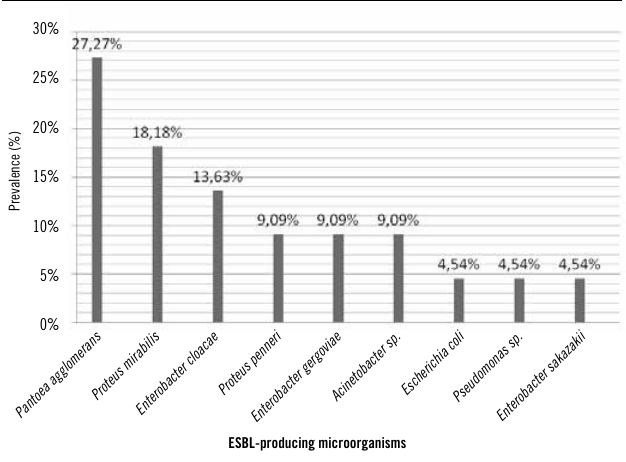
figurE 3 − Phenotypic prevalence of ESBL-producing strains ESBL: Extended-spectrum